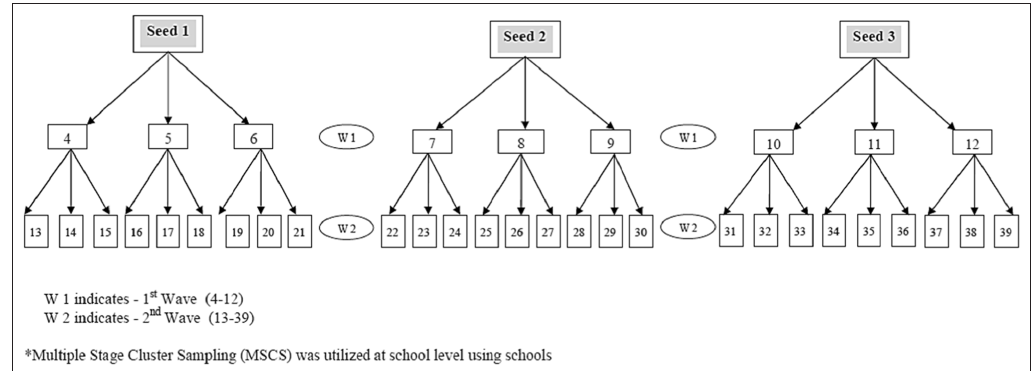
Figure 1: Respondent driven sampling for out of school youth – a graphical illustration of two sampling waves. Taken from “Health Risk Behaviours, life skills and socio-economic status survey of Out of School Youth in South Africa: An investigation into sexual and other behaviours that place the next generation at risk” by Reddy et al., 2011, Cape Town: South African Medical Research